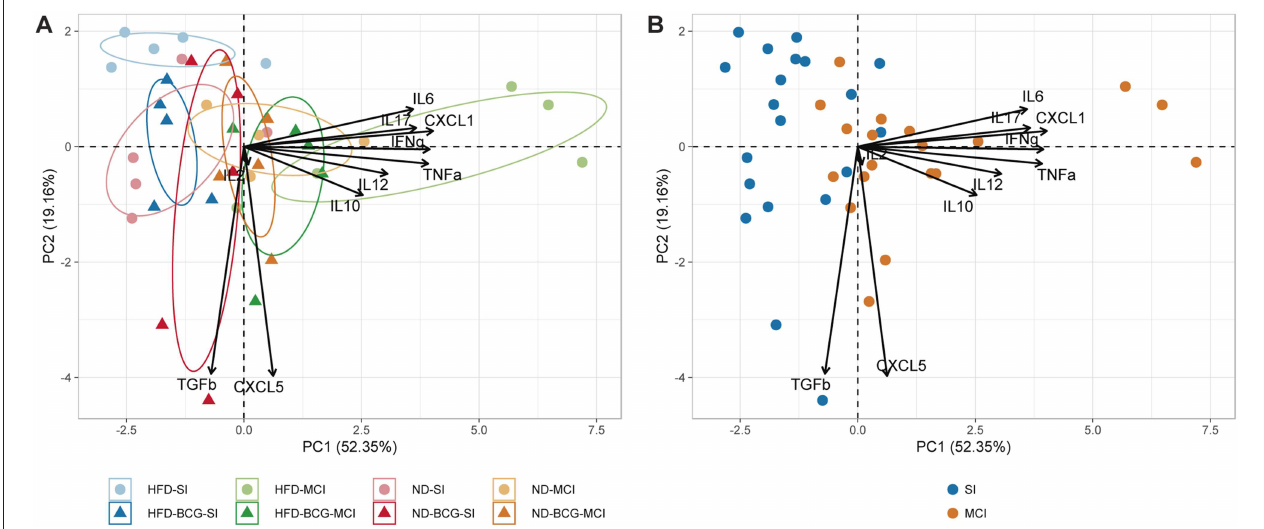
FIGURE 5 | Principal component analysis of inflammatory mediators. (A) Representation of animals according to experimental groups with 95% confidence ellipses. (B) Samples colored by type of